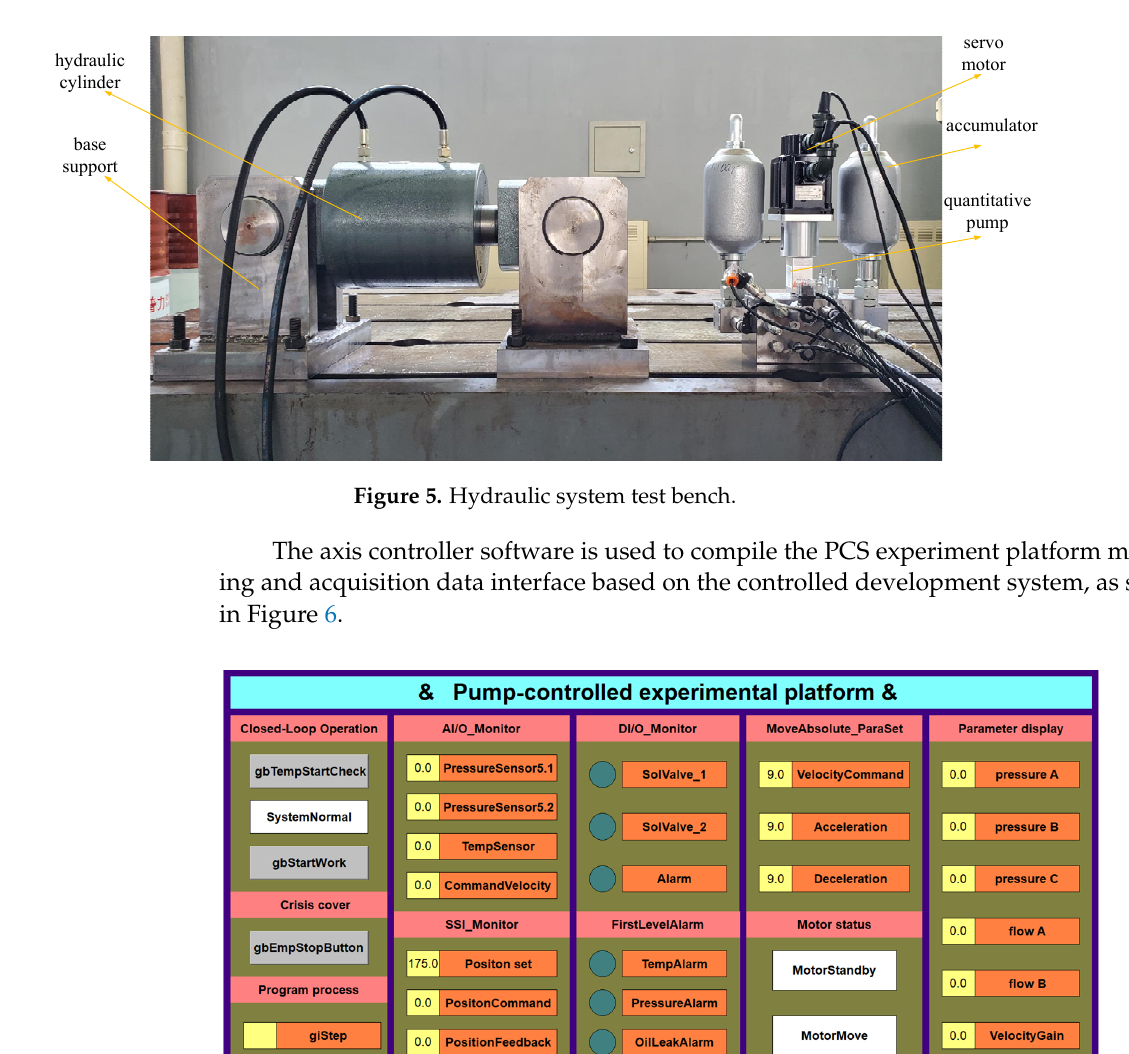
Figure 4. Schematic diagram of electrical framework.